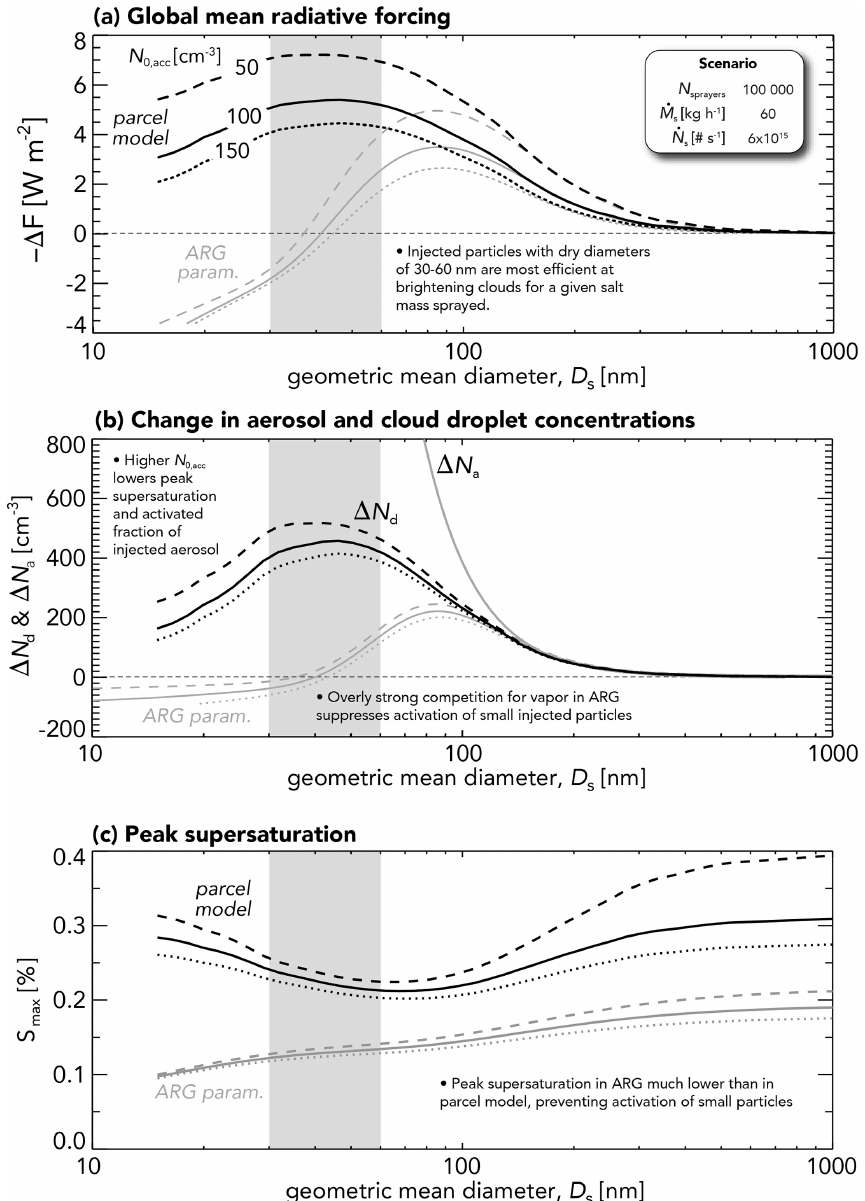
Figure 7. (a) Global mean radiative forcing − (cid:49)F for a fixed salt mass spray rate (based on scenario 2; see the legend) as a function of injected particle geometric mean diameter D s for three unperturbed accumulation-mode aerosol concentrations N 0 , acc = 50, 100, and 150cm − 3 . Black curves show the results from the parcel model and gray curves from the ARG parameterization. (b) Change in mean cloud droplet concentration (cid:49)N d and aerosol concentration (cid:49)N a in regions where sprayers are operating. (c) Peak supersaturation in the updraft. The gray shaded box indicates the most effective range of D s